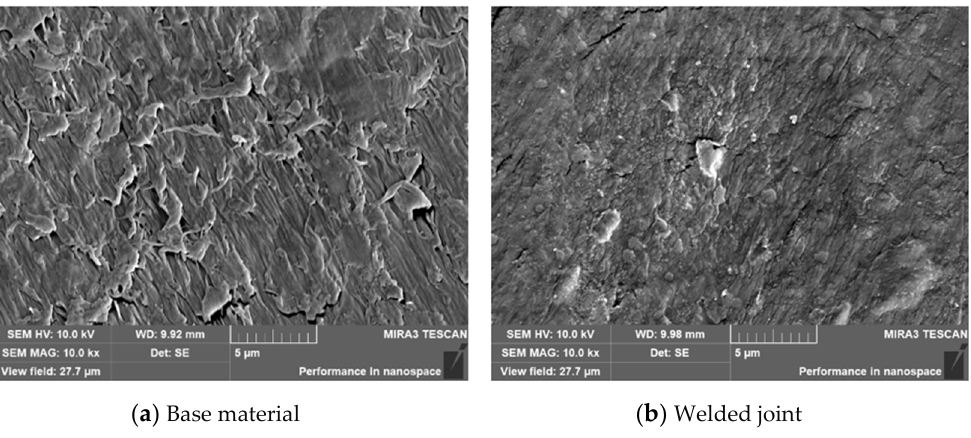
Figure 2. SEM micrographs of the base material and welded joint of HDPE. Table 2. The defect diameter, wall thickness, defect ratio and creep life of the specimens.